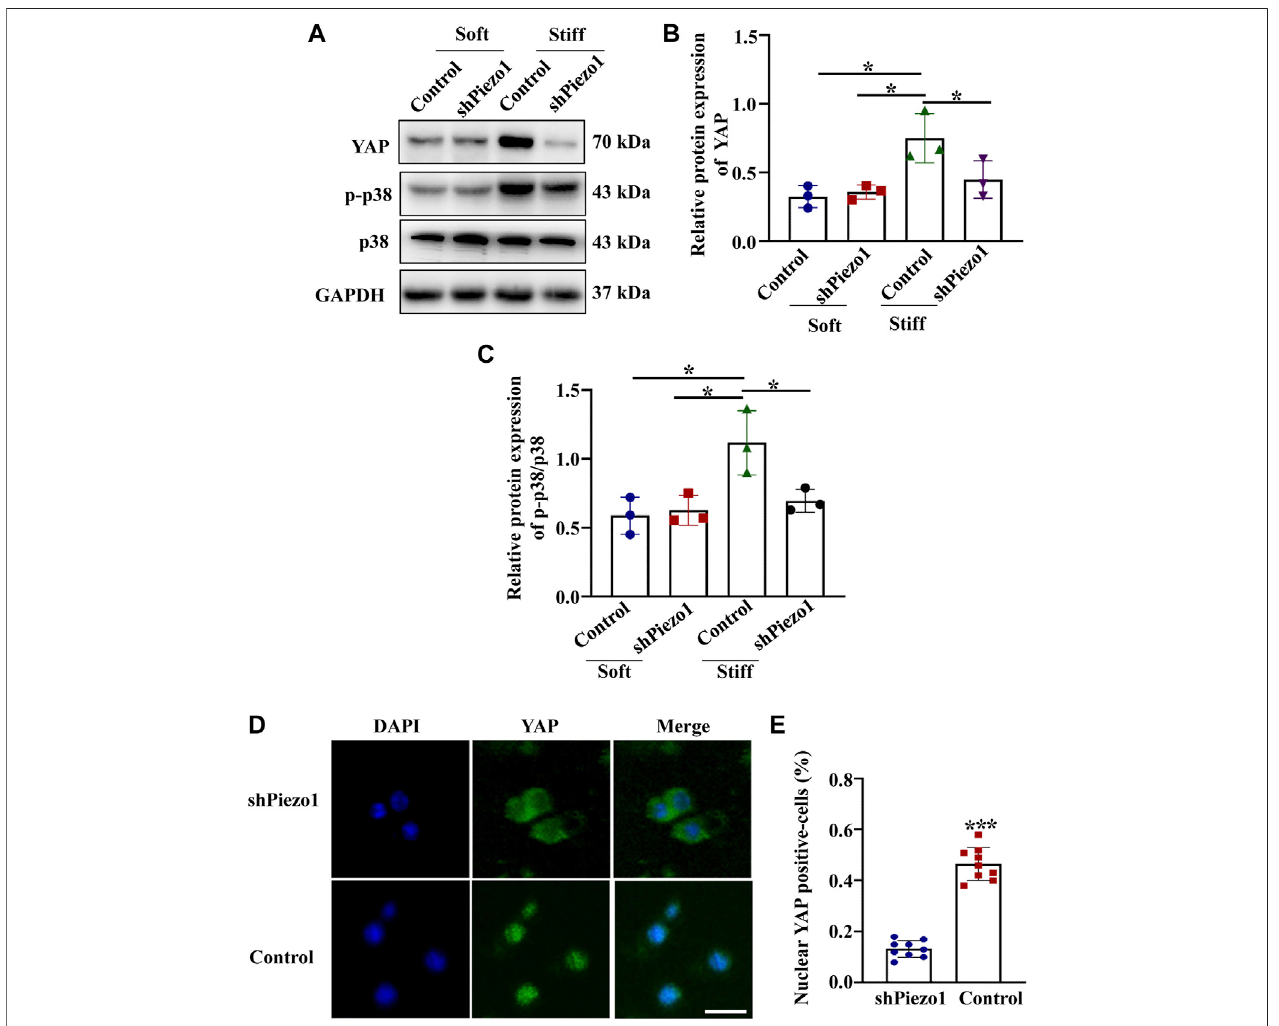
FIGURE 6 | Piezo1 knockdown reduced YAP and p-p38 expression. MCs were transfected with shNC or sh Piezo1 and grown on soft and stiff gels. (A) Representative western blot bands of YAP, p-p38 and p38. Semi-quantitative measurement of YAP (B) and p-p38/p38 ( n (cid:1) 3 * p < 0.05, ** p < 0.01, *** p < 0.001). (D) Representative photomicrographs show fl uorescence staining with anti-YAP after MCs were transfected with shNC or sh Piezo1 and grown on stiff gels. Scale bar (cid:1) 25 µm. (E) The percentage of cells with predominantly nuclear YAP staining. ( p < 0.001).